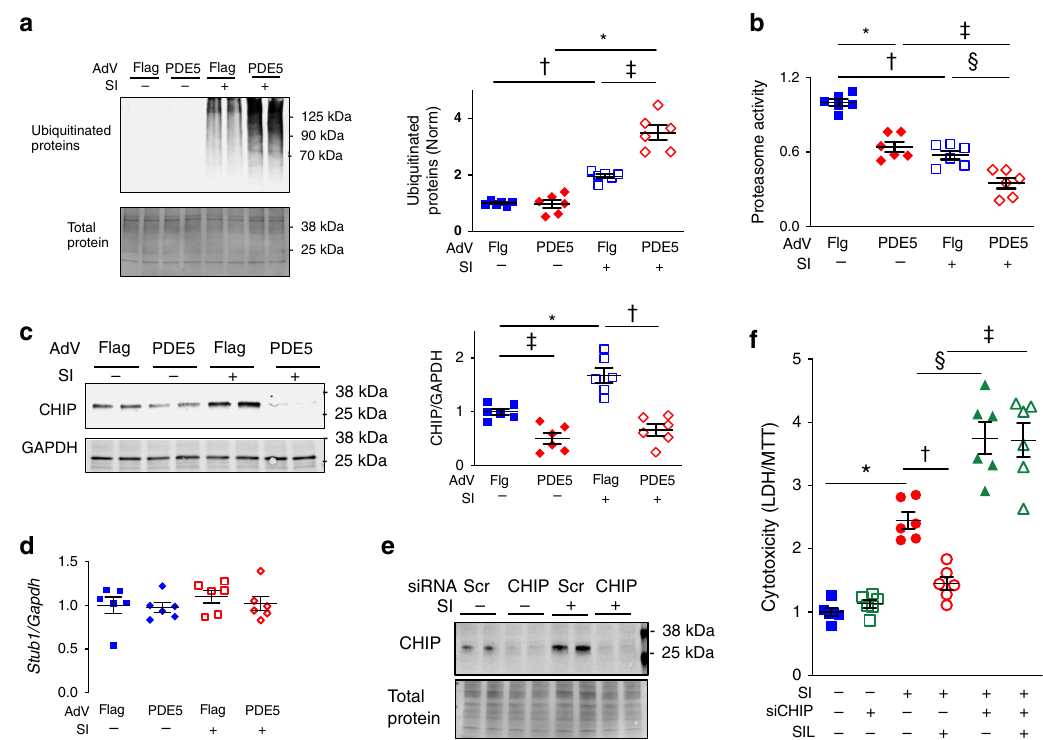
Fig. 1 Effect of simulated ischemia (SI) + / − PKG blockade on ubiquitinated proteins and CHIP. a Left: example immunoblot for ubiquitinated proteins from myocytes infected with adenovirus (AdV) for Flag or PDE5A-Flag (PDE5), the latter to suppress PKG activation (c.f. Supplementary Fig. 1a, b). Cells are then subjected to normal conditions or SI. Right : summary results, n = 6 biological replicates/group, 2WANOVA, Tukey multiple comparisons test (mct): * p < 10 − 8 , † p = 0.0014, ‡ p = 4 × 10 − 6 . b Blocking PKG activation by PDE5A oe reduces proteasome activity similarly at baseline or after SI ( n = 6 biological replicates/group, 2WANOVA, Tukey mct: * p = 8 × 10 − 6 , † 8 × 10 − 7 , ‡ 1 × 10 − 4 , § 0.002). c CHIP protein expression increases after SI but this is blocked by PDE5Aoe, 6 biological replicates/group, 2WANOVA, Tukey mct, *0.001, † 7 × 10 − 6 , ‡ 0.015. d CHIP mRNA expression is unaltered between groups, six biological replicates/group; 1WANOVA, p = 0.7. e Immunoblot showing ef fi cacy of CHIP protein suppression in basal and SI conditions after incubation with speci fi c but not scrambled (Scr) silencing RNA (siRNA), summary in Supplementary Fig. 1c. f LDH/MTT ratio in NRCMs exposed to control or SI conditions, + / − siRNA to CHIP (100 pM) or Scr, and with or without PDE5A inhibitor, sildena fi l (SIL, 1 µ M). n = 6 biological replicates/group; shown in each summary